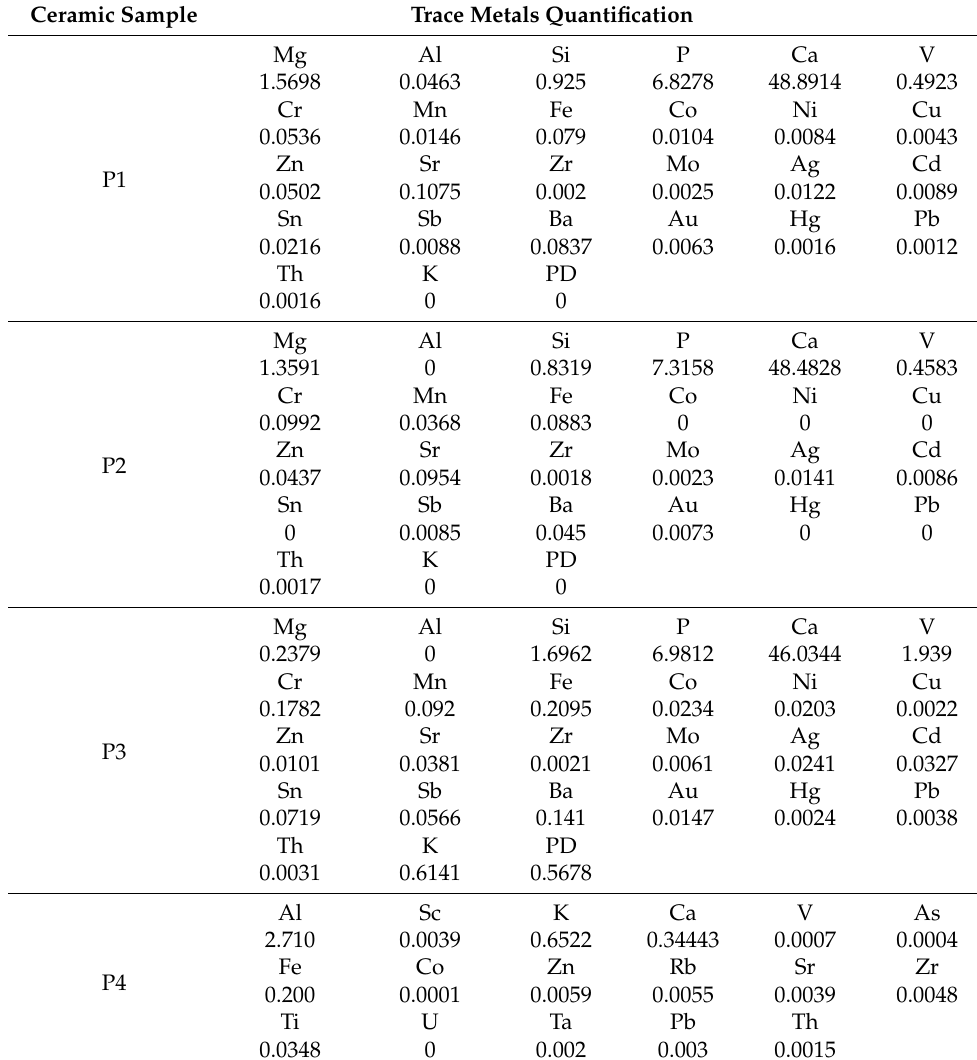
Table 3. Metals composition of ceramics